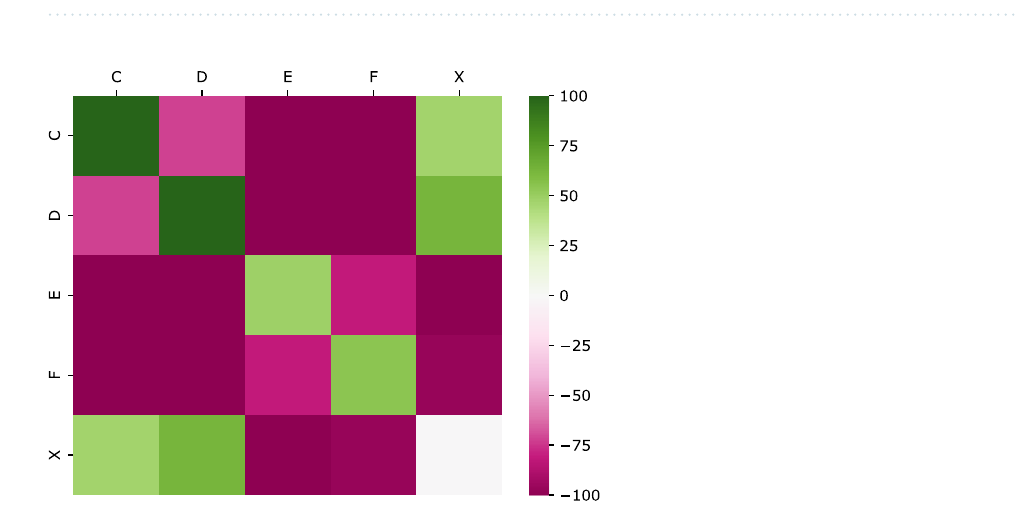
Figure 3. Heat-map corresponding to Z matrix of Pokec social network. Values in the color scale have been cut 100, 100 to interval [− ]